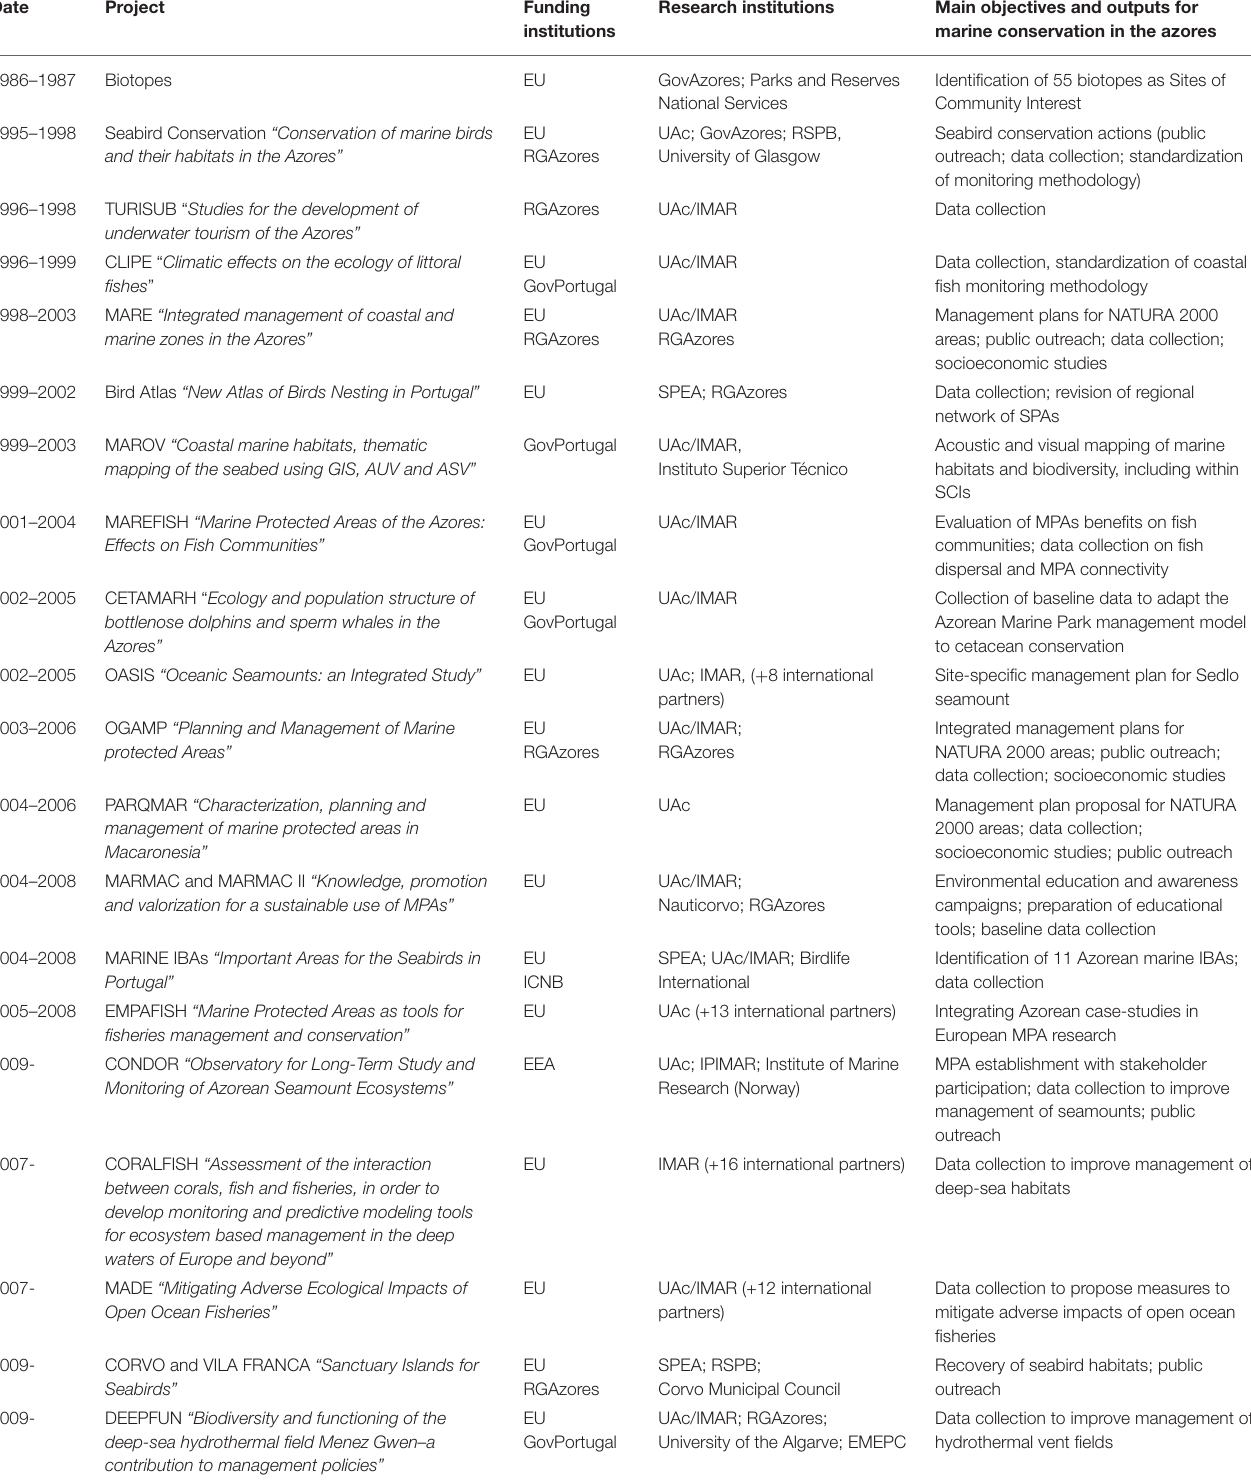
TABLE 2 | Scientific projects carried out in the Archipelago of the Azores that focused on marine conservation and provided relevant outputs for the establishment of marine protected areas in the region, including their main funding sources and institutions